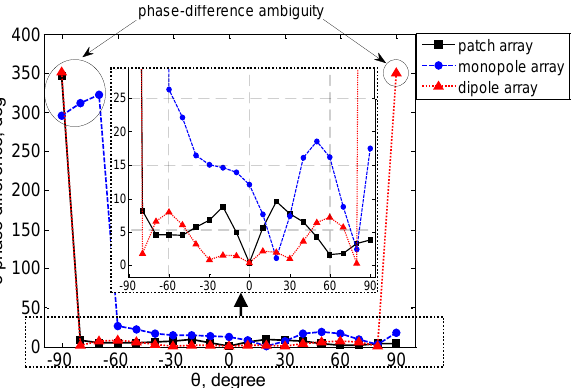
Figure 8. DOA estimation accuracy of the three antenna arrays against DOA (θ).